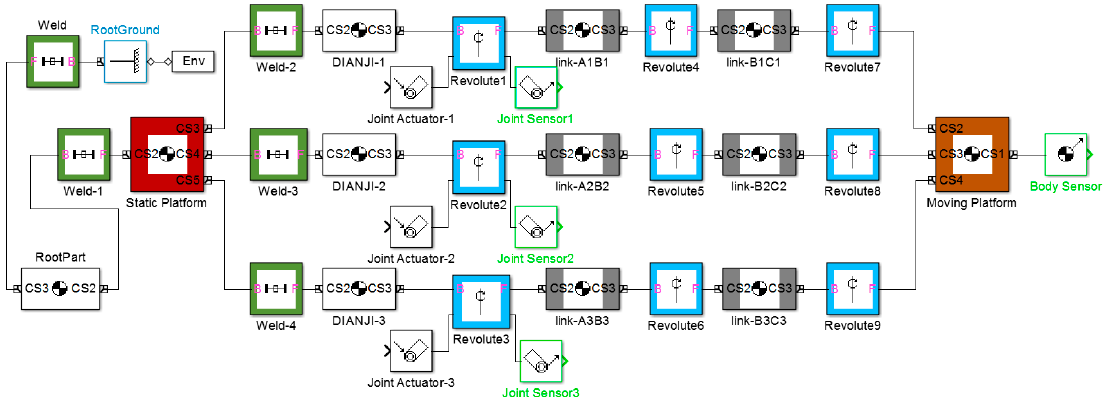
Figure 4. The virtual bench of the planar 3-RRR parallel industrial robot.